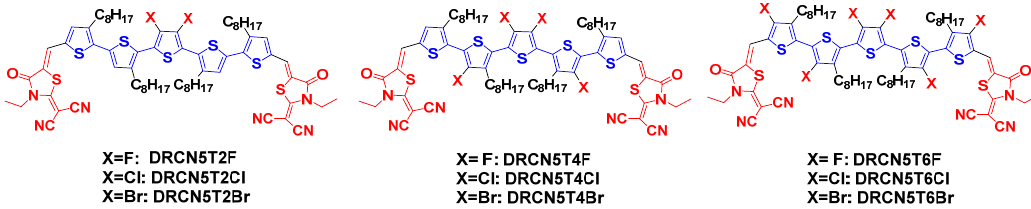
Figure 2. Molecular structures of DRCN5T2X, DRCN5T4X, and DRCN5T6X (X = F, Cl, and Br).